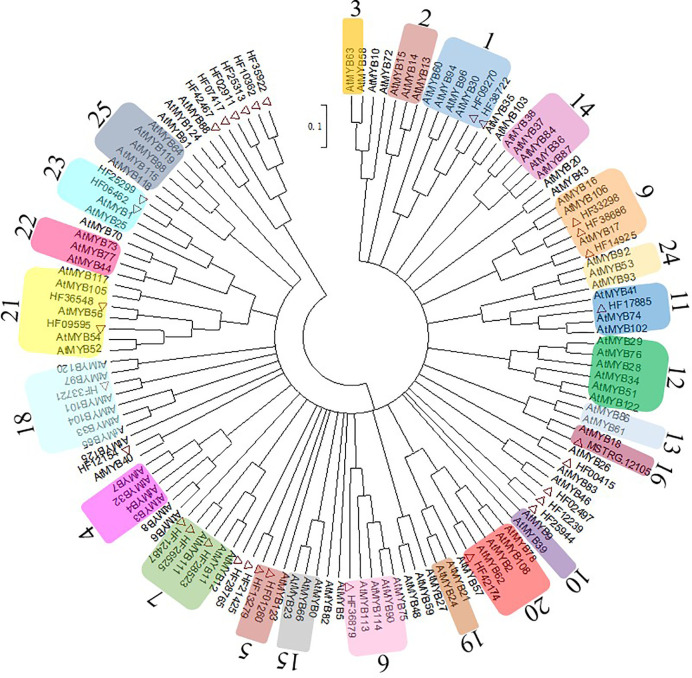
Evolutionary relationships of MhMYBs. Full-length amino acid sequences of R2R3-MYBs from the chrysanthemum transcriptome dataset and arabidopsis genome were first aligned using ClustalW in MEGA6. The phylogenetic tree was constructed according to the neighbor-joining method. Branches corresponding to partitions reproduced in less than 50% of the bootstrap replicates were collapsed. The evolutionary distances were computed using the p-distance method. Thirty-two MhMYBs marked red triangle were identified from the RNA sequencing data of M. halliana. The arabic numerals on the cycle indicated gene families.